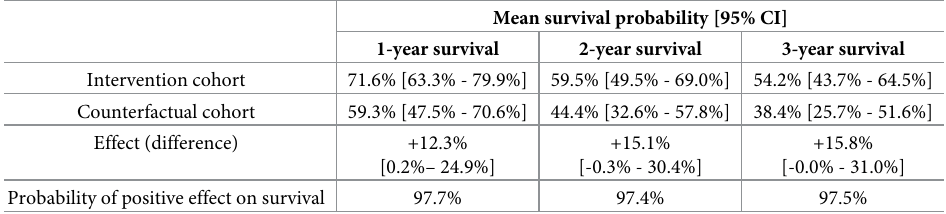
Table 3. Counterfactual analysis of overall survival, in the hypothetical, bootstrapped weighted